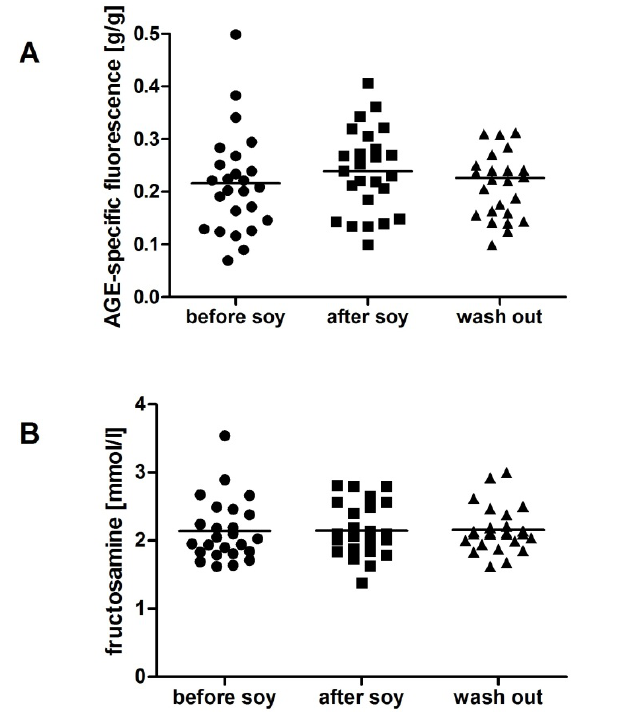
Figure 4. Carbonyl stress parameters in men. Soy intake did not affect advanced glycation end products (AGE-specific fluorescence; A ). No changes were found in plasma fructosamine levels ( B